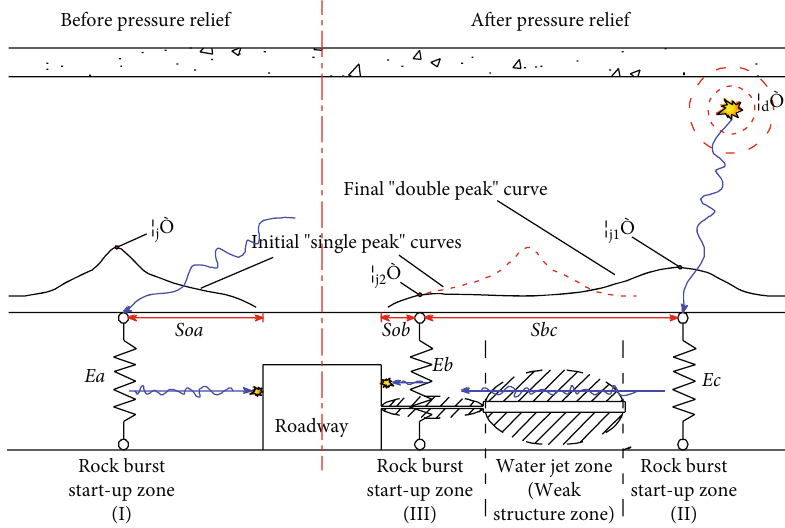
Figure 9: The prevention mechanism schematic diagram of rock burst in roadway